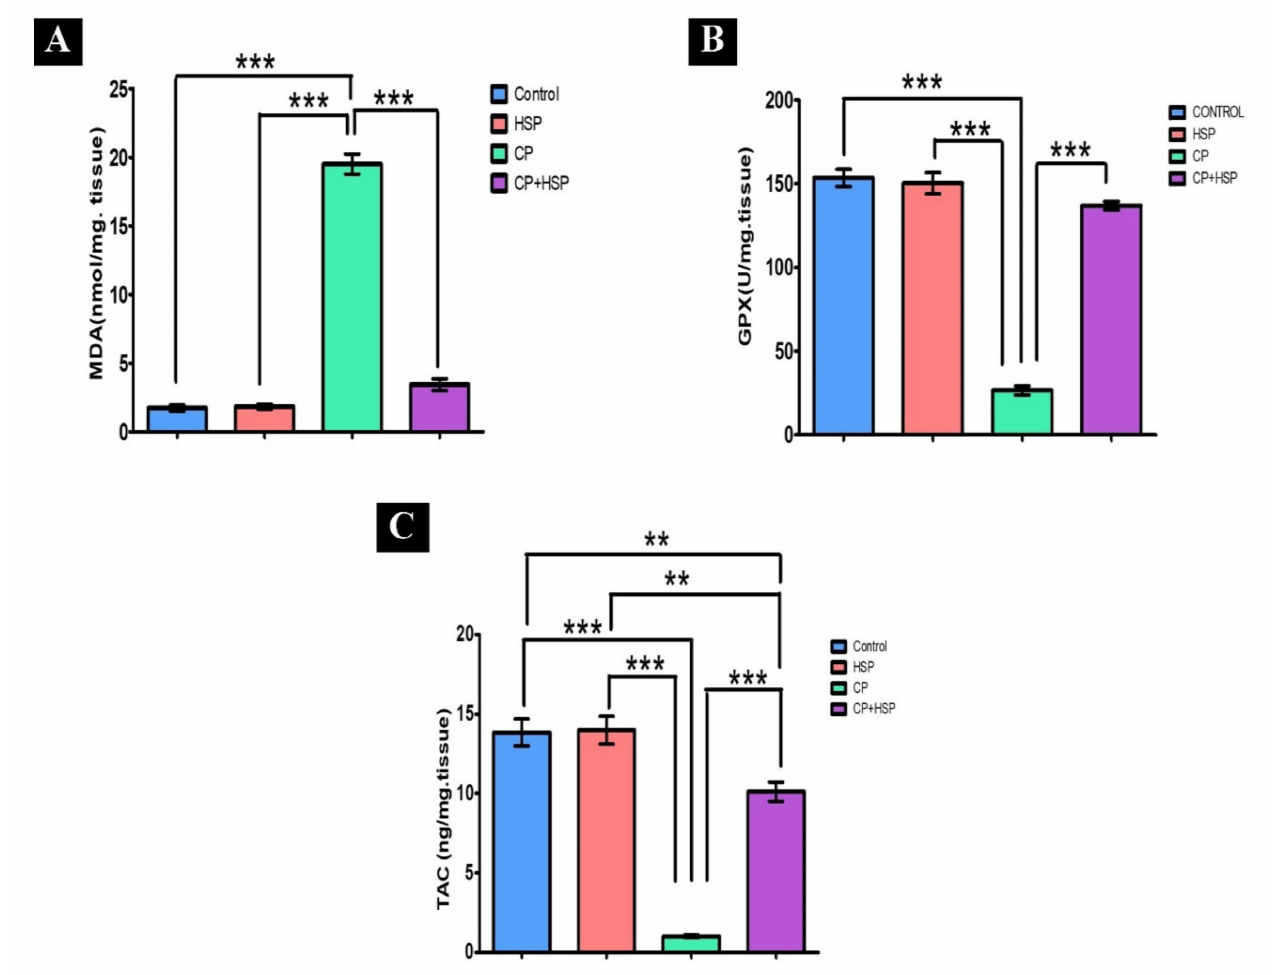
Figure 2. Effect of hesperidin administration in cyclophosphamide-induced testicular impairment in male rats on testicular lipid peroxidation and oxidative stress markers ( A – C ). ( A ) Testicular MDA level (nmol/mg. tissue), ( B ) testicular GPx level (U/mg. tissue), and ( C ) testicular TAC level (ng/mg. tissue). Data are expressed as means ± SEM. N = 8. **, *** indicate significant difference ( p <